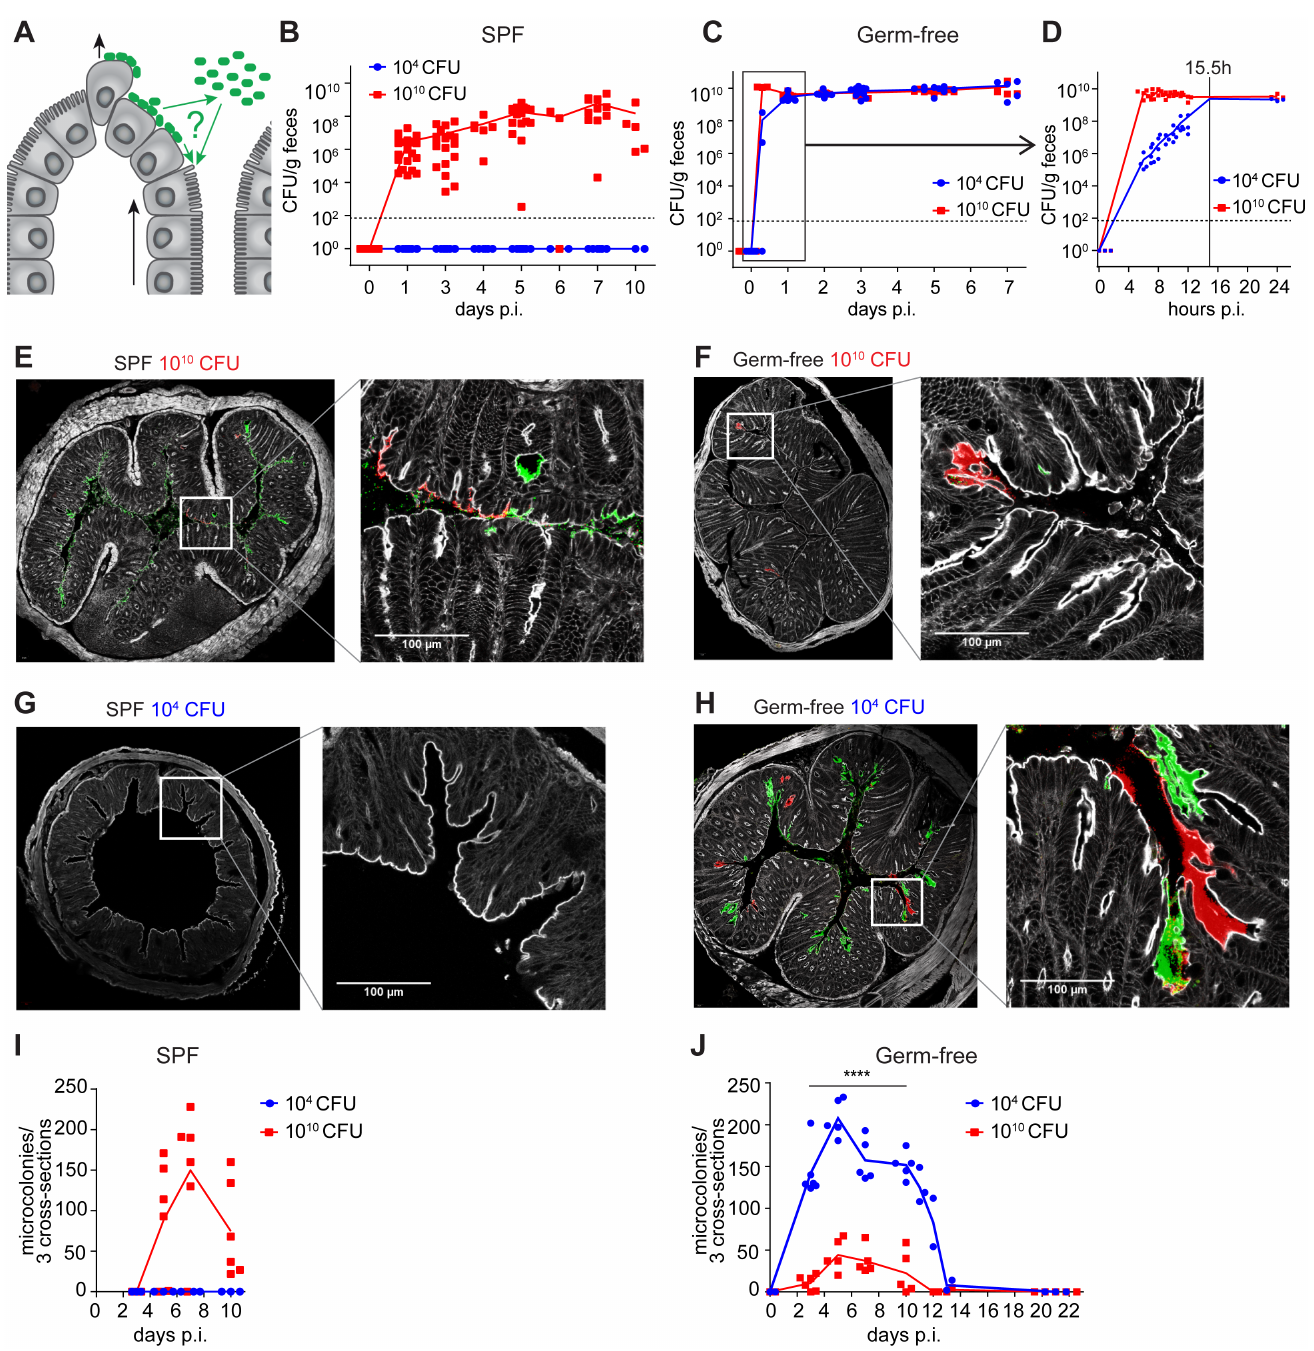
Fig 1. Dynamicsof Citrobacter rodentium infection in SPF and germ-freewild-type mice. ( A ) Schematicof possibleroutes of epithelialinfection shapingA/E lesion development and renewalin the face of continuous epithelialregeneration. Black arrows indicate directionof epithelialcell migration and luminalexfoliation. Green arrows indicatepossibleroutes of bacterial infection, with or without luminalplanktonic stage. ( B-D ) Luminalcolonization quantitatedby bacterialplating from feces of SPF mice (panel B; n = 12–21 per group and time point) and germ-free mice (panelC; n = 3–15 per group and time point) followinginoculation with 10 10 (red squares) and 10 4 (blue circles) CFU/mouse, respectively.(D) Early colonizationin mice (n = 4 per group) sampledevery hour duringthe first 12 hours after gavage. Fitted exponential curves were used to extrapolatethe time to reach levels of 2.5x10 9 CFU/g in the animalsinoculated with 10 4 CFU. The averageof these 4 values is representedby the vertical dotted line (at 15.5 h). ( E-H ) Representative fluorescentmicroscopy images of distal colon cross sections of SPF (E and G) and germ-free (F and H) mice infected with 10 10 (E and F) and 10 4 (G and H) CFU/mouse of C . rodentium analyzedon day 7 post infection. All individual mice depicted were infected with a 1:1 mixture of bacteriacarrying a mCherry (red) or GFP (green)fluorescentprotein expressionplasmid. Grey, F-actin stainedwith phalloidin;green, GFP-expressing C . rodentium ; red,